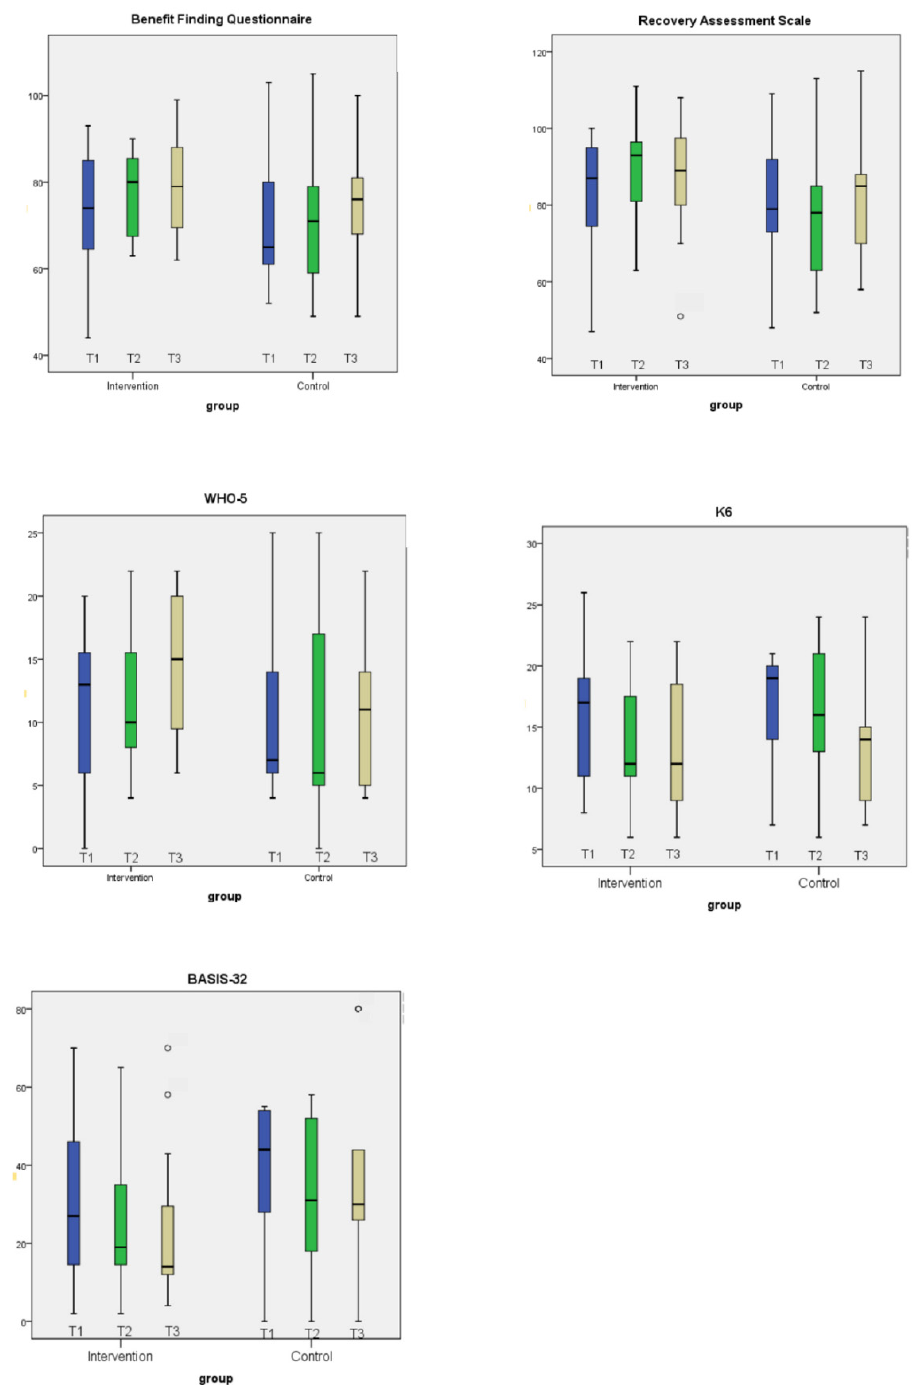
Figure 2. The box plots of the scores in each scale from baseline to T3 (3-month follow up) in intervention group ( n = 15) and control group ( n = 9).